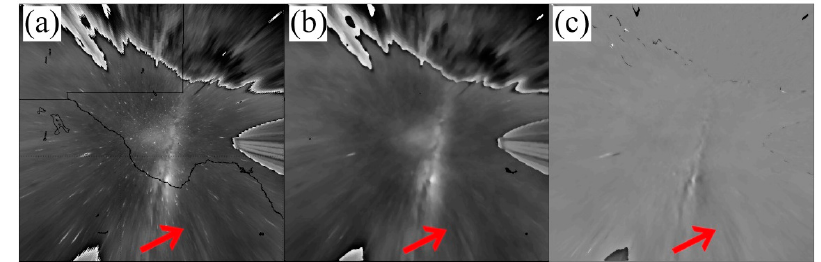
Figure 3. ( a ) Unwrapped OH image of the mesospheric bore event at 08:52 UT 4 May 2014, ( b ) 2D-median filtered image, ( c ) time-difference image.